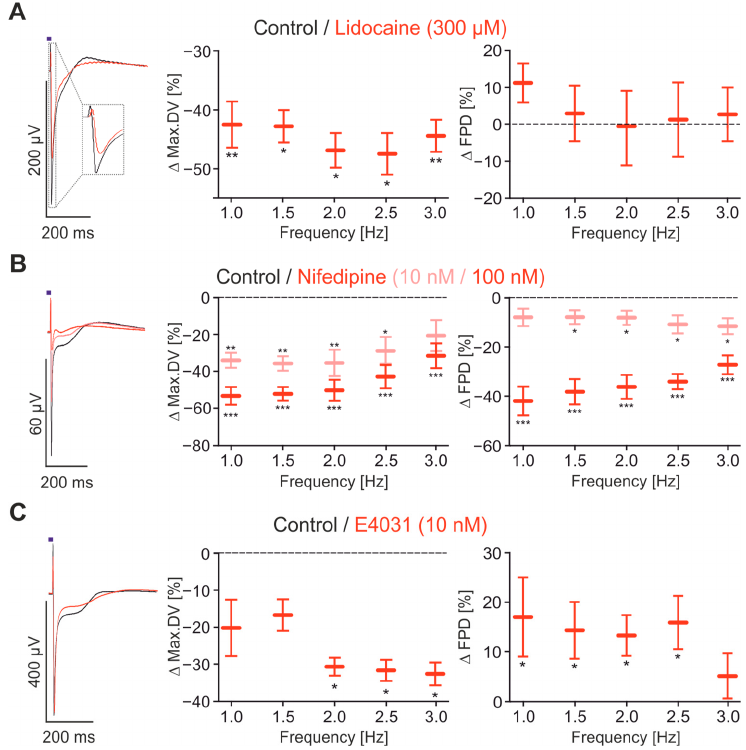
Figure 4. Pharmacological characterisation of FP parameters. ( A – C ) Overlay of representative FP optically paced at 1 Hz ( left ) before ( black ) and after drug application (red), and statistical analysis of the relative changes of max.DV ( middle ) and FPD (right) at the frequencies 1–3 Hz; ( A ) effects of 300 μ M Lidocaine ( n = 7–8); ( B ) effects of 10 nM ( n = 7) and 100 nM ( n = 11) Nifedipine; ( C ) effects of 10 nM E4031 ( n = 12–17). * p < 0.05, ** p < 0.01, ***p < 0.001.